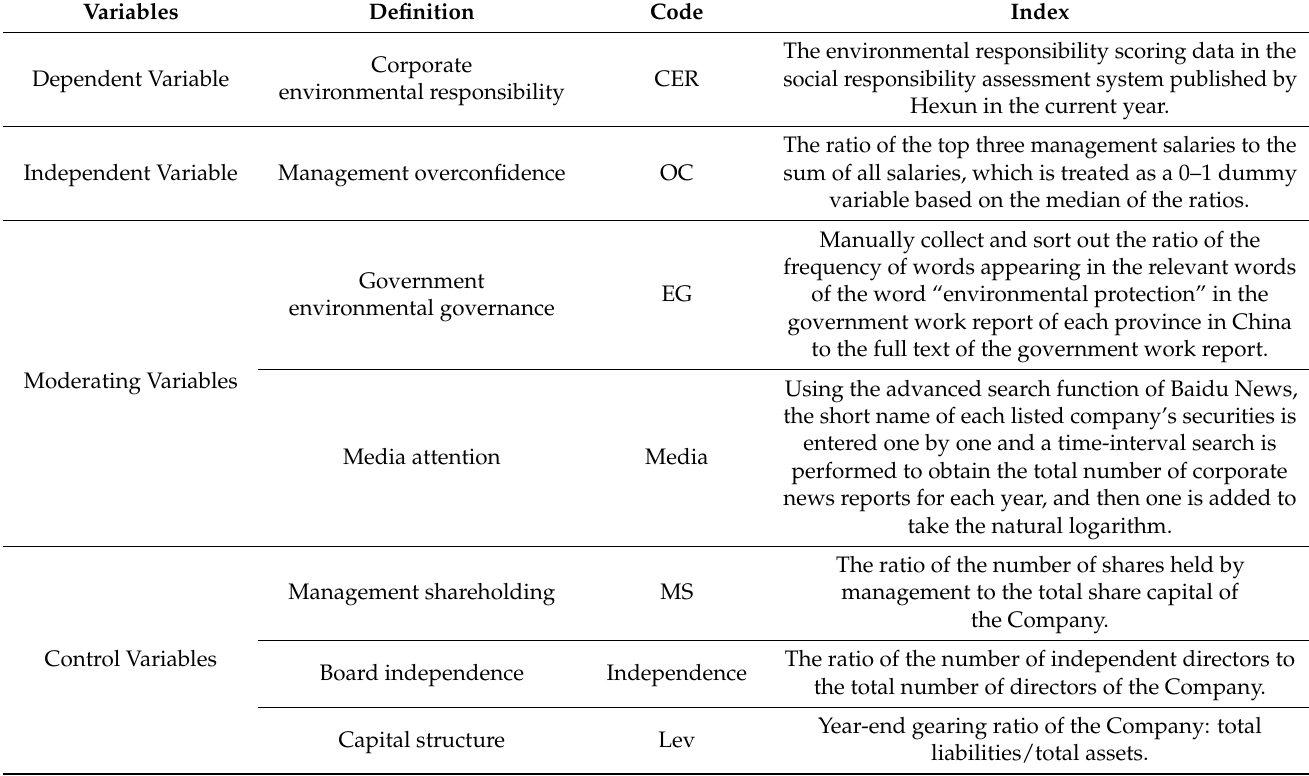
Table 1. Description of